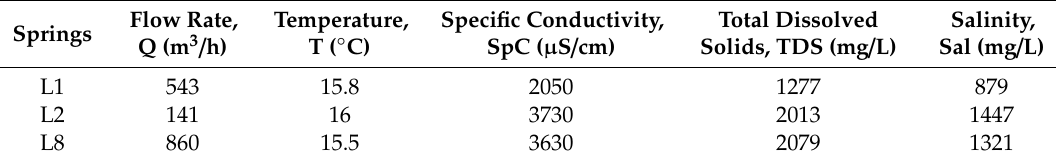
Table 1. Flow rate and some physicochemical values of the spring waters. Each value is the mean of measurements taken every 15 days in June, July, and